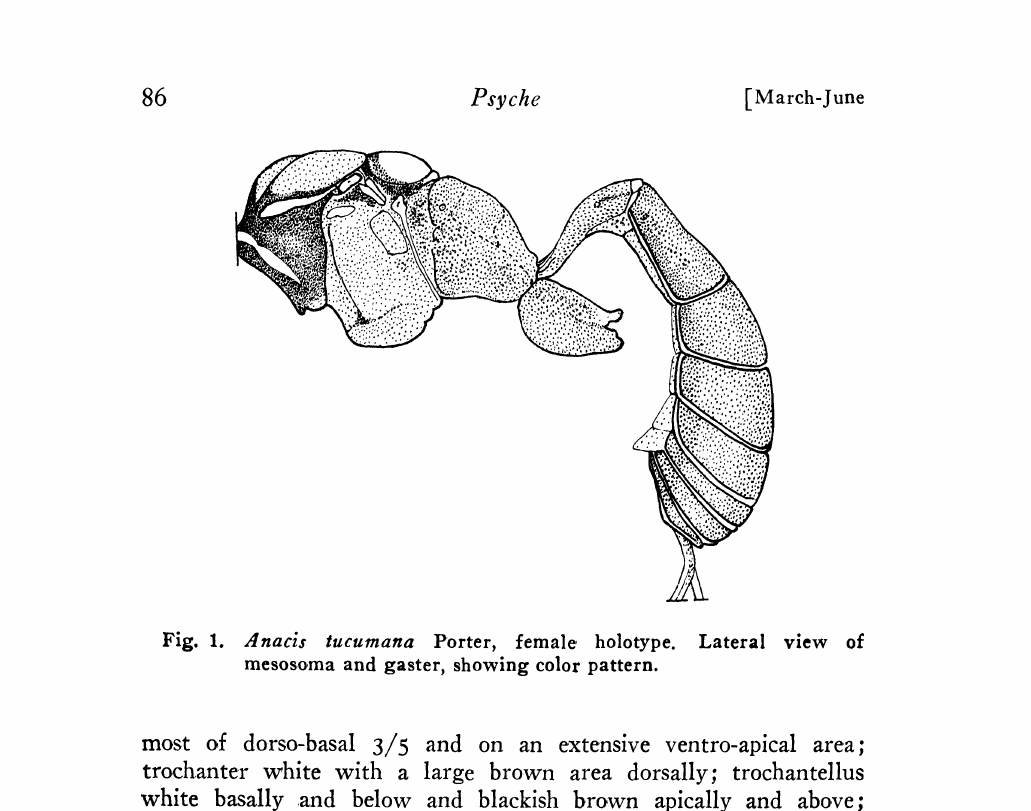
Fig. 1. Anacis tucumana Porter, female holotype. Lateral view of mesosoma and gaster, showing color pattern. most of dorso-basal 3/5 and on an extensive ventro-apical